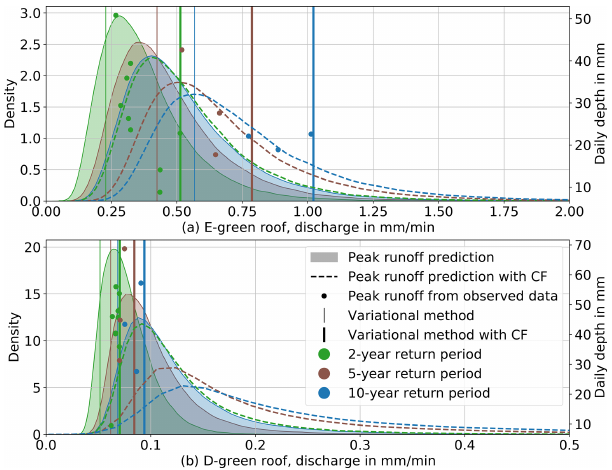
Figure 9. Performance depending on the return period in Trond- heim for the extensive green roof (a) and the detention-based ex- tensive green roof (b) . The transparent coloured area is the distribu- tion based on the hybrid event-based downscaling under current cli- mate; the dotted line denotes the use of CF; the points represent the peaks runoff of runoff events from observed precipitation; the ver- tical lines the results found based on the variational method (VM): 2-, 5- and 10-year return periods are